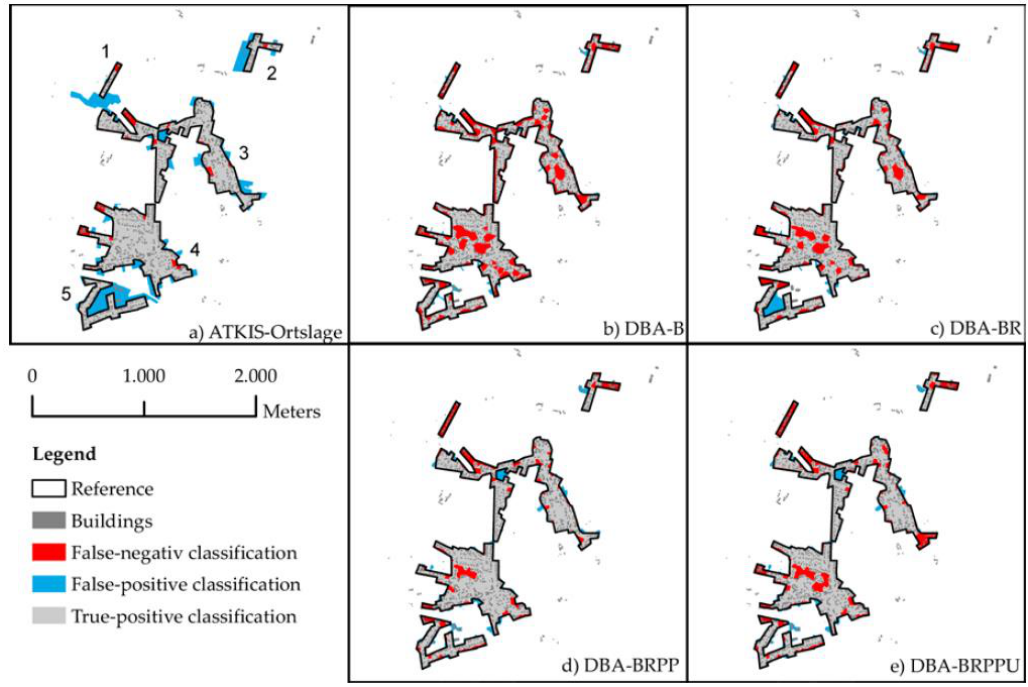
Figure 7. Examples of optimized boundaries of the: ( a ) ATKIS ® -Ortslage; ( b ) variant DBA-B; ( c ) variant DBA-BR; ( d ) variant DBA-BRPP; and ( e ) variant DBA-BRPPU (Official building polygons, ATKIS ® Base-DLM© Geobasis-DE/BKG (2011)).